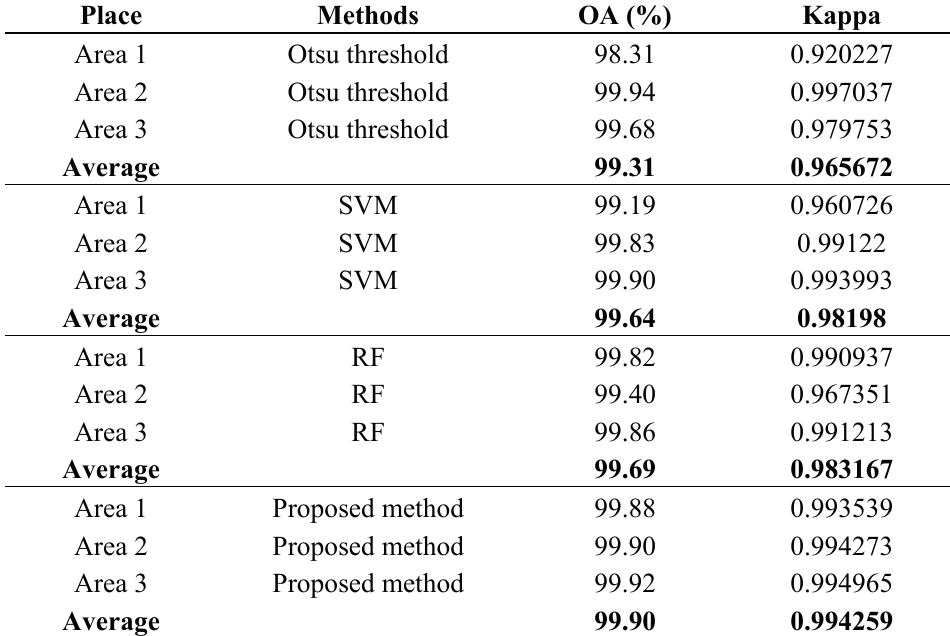
Table 3. Water body classification comparison of three